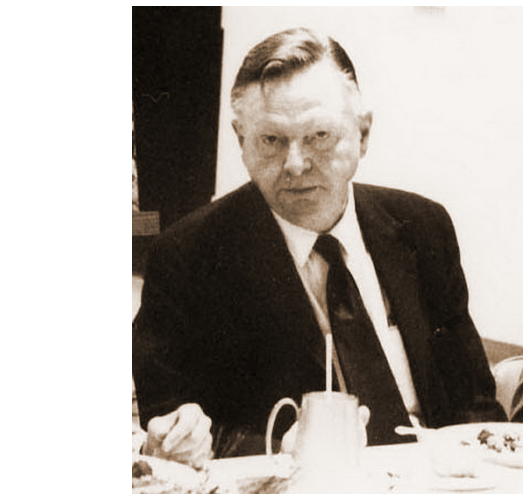
Figure 1. Prof. Dr Helmut Hofer was the first scientist to submit a memorandum on the establishment of a German primate centre in 1964 (picture from the Tulane National Primate Research Center in Covington, Louisiana, USA).